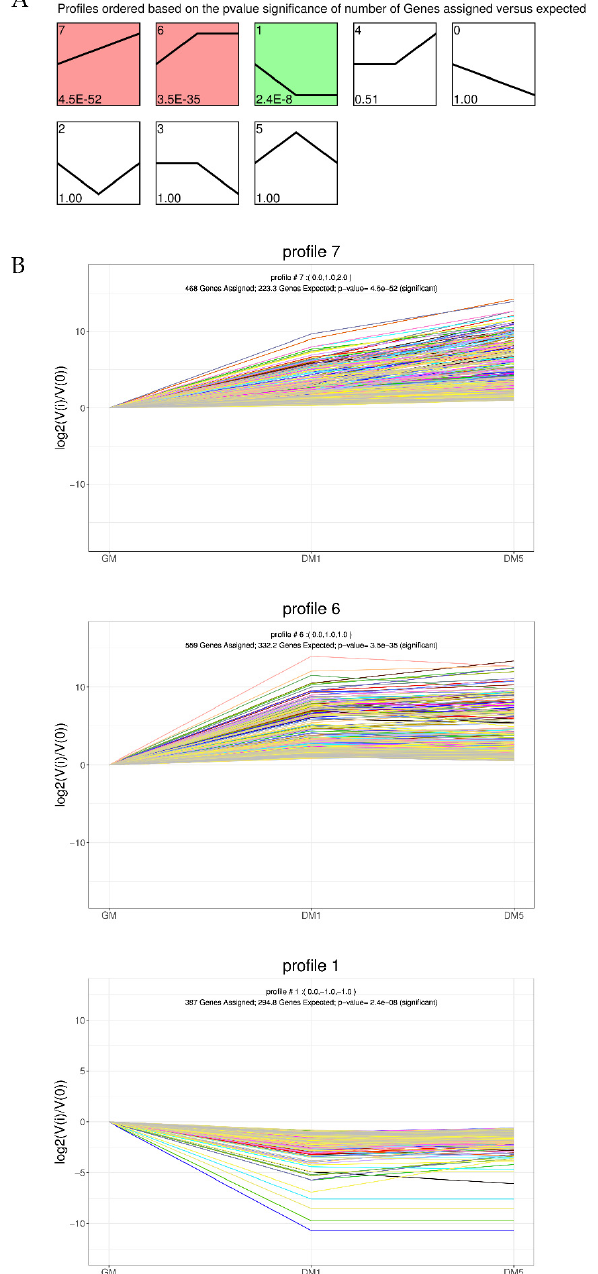
Figure 4. STEM analysis of the DEGs’ expression profiles. ( A ) Trend analysis of the different expression genes; color intensity denotes enrichment. ( B ) Three significant clusters of DEG profiles across all three stages.